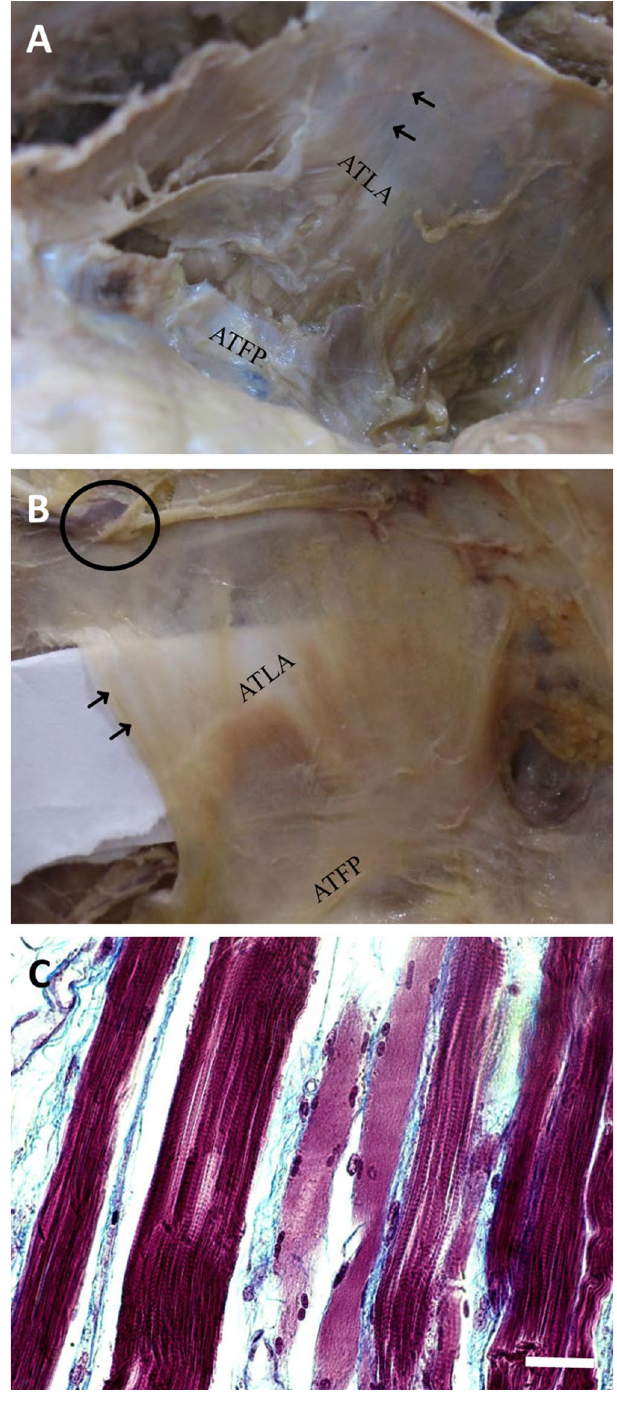
Figure 3. Photographs of the inner side of a hemipelvis displaying muscle fibers within the obturator fascia. ( A ) Some muscle fibers (arrows) can be observed within the obturator fascia above the arcus tendinous levator ani (ATLA) in the right pelvis. ( B ) These muscle fibers (arrows) could be clearly observed by placing a white piece of paper between the obturator fascia and obturator internus muscle in the left pelvis. ( C ) Histological section revealing muscle fibers within the obturator fascia are skeletal muscle type. These striated muscle fibers are stained in red, and the abundant collagen fibers of the connective tissue between muscle fibers are stained in blue/green through Masson’s trichrome staining. The obturator canal is labeled by a circle. ATFP arcus tendinus fasciae pelvis. Bar, 20